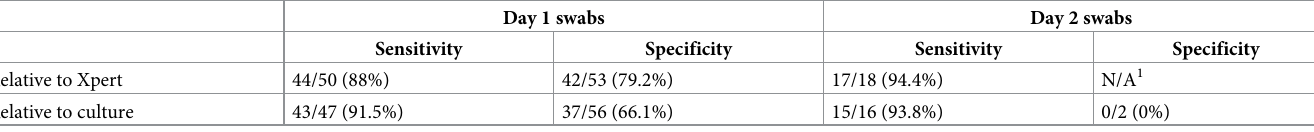
Table 3. Sensitivity and specificity of OSA relative to sputum GeneXpert Ultra and culture.